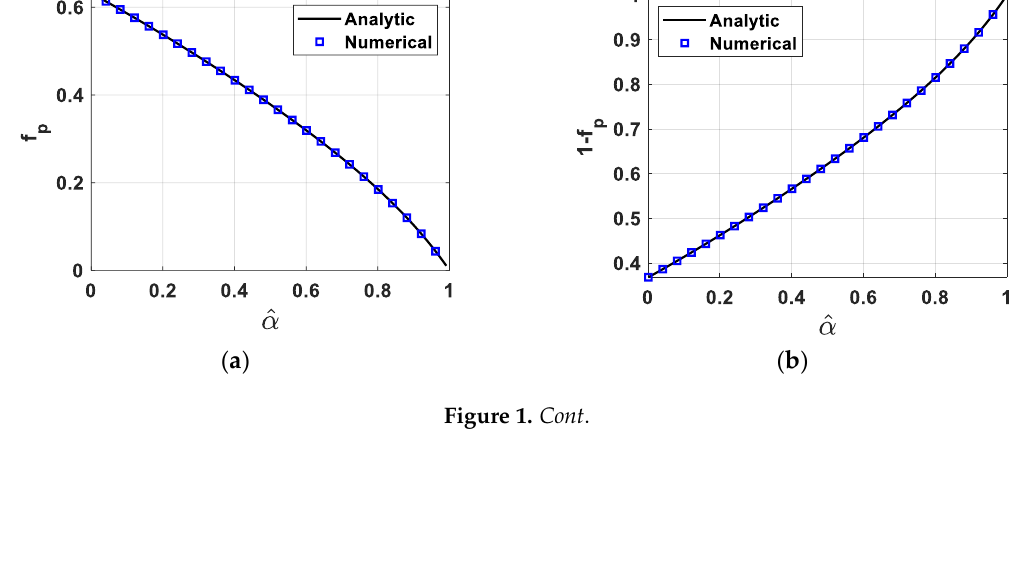
( d ) Figure 1. Analytical solutions from Equation (22) (Section 3.1) and numerical solutions from Equation (23) are shown for biexponential model parameters ( a ) f p , ( b ) 1- f p , ( c ) D 0 , and ( d ) D, as functions of the stretched exponent 𝛼 ̂ , both for 𝑏 = 0, 1, 2, 3 and 𝐷 𝑠𝑒 = 1/3 .